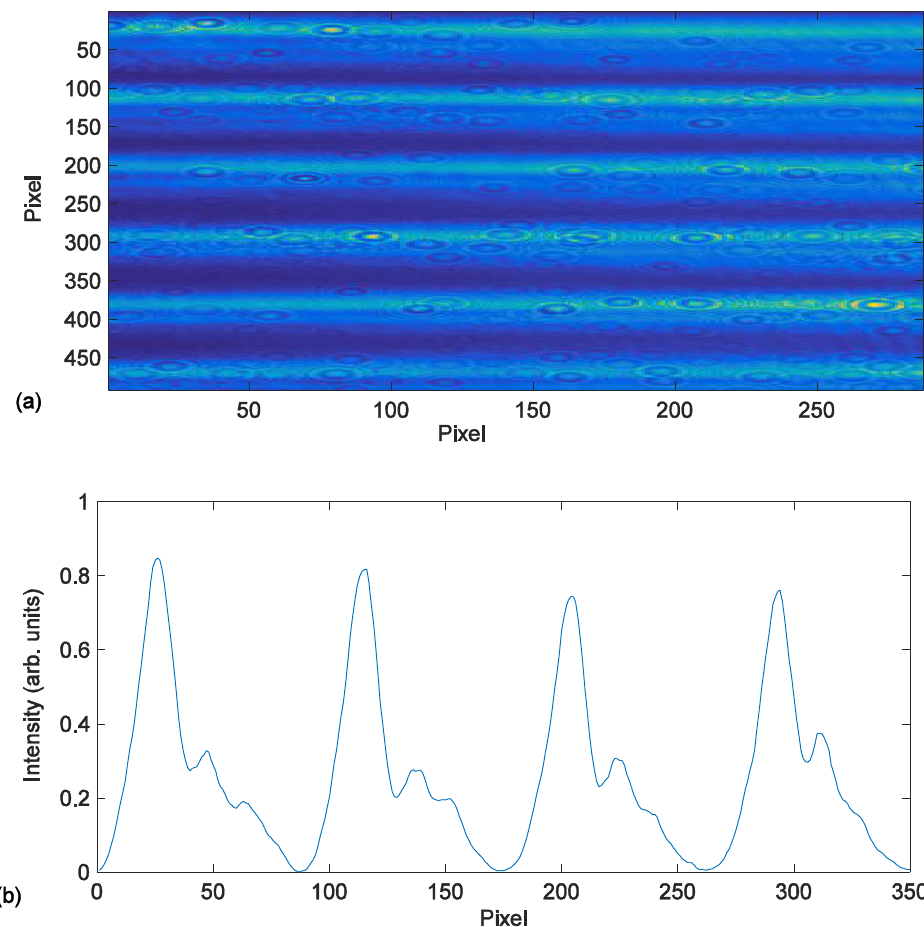
Figure 2. ( a ) The image on the photopolymer provided by the LCoS and captured by the CCD camera; and ( b ) the intensity profile provided by the LCoS across a vertical line of the image in ( a